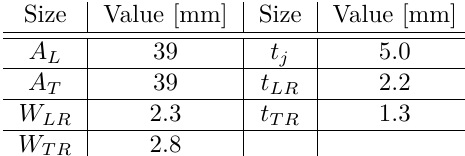
Table 2. Sizes of geogrid TENSAR